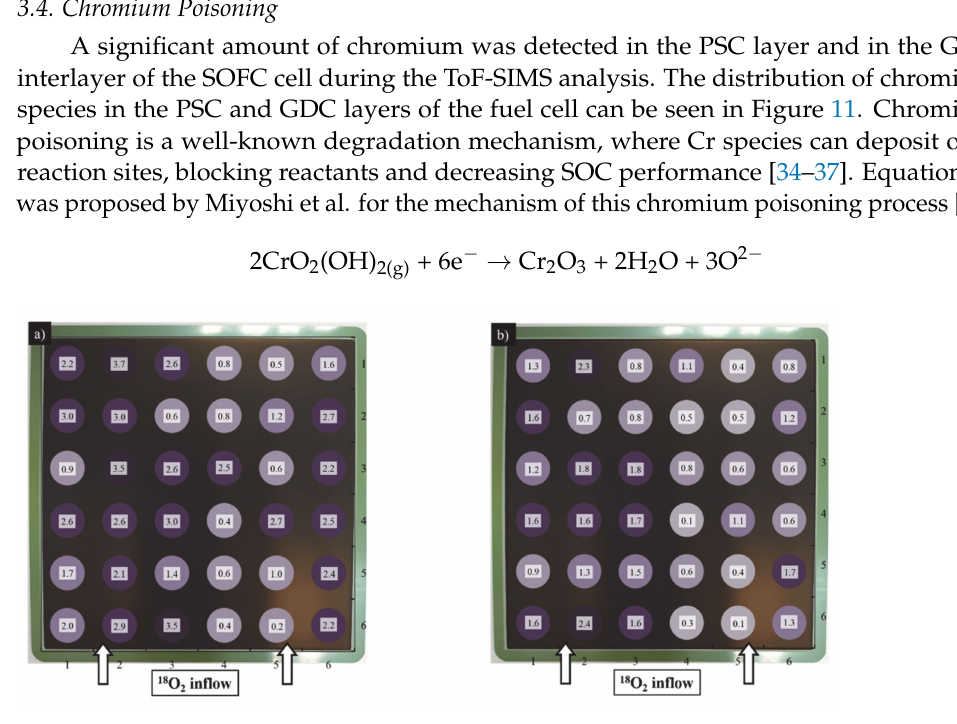
Figure 11. Chromium distribution in the PSC electrode ( a ) and in the GDC ( b ) chemical barrier layer of the Ni-YSZ|YSZ|GDC|PSC SOFC short stack. The values represent the ratio of Cr counts to the total positive ion counts. The white arrows denote the direction of air flow at the oxygen electrode